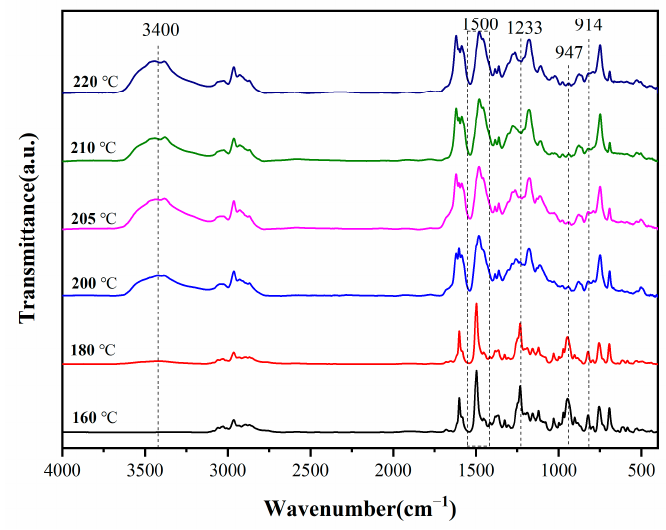
Figure 7. FTIR spectra of PBZ/ DDSQ-EP (2 wt%) resins at different temperature.